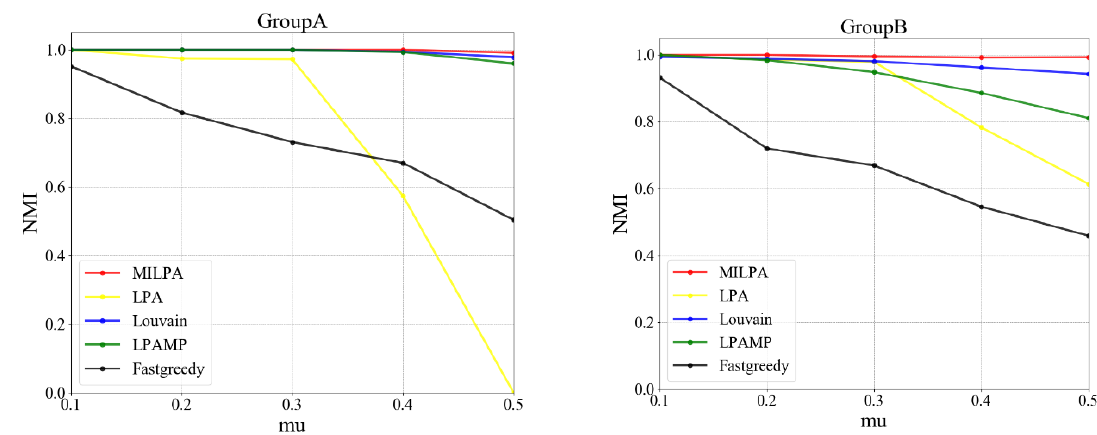
Figure 3. NMI of five methods in LFR networks of Group A and B .